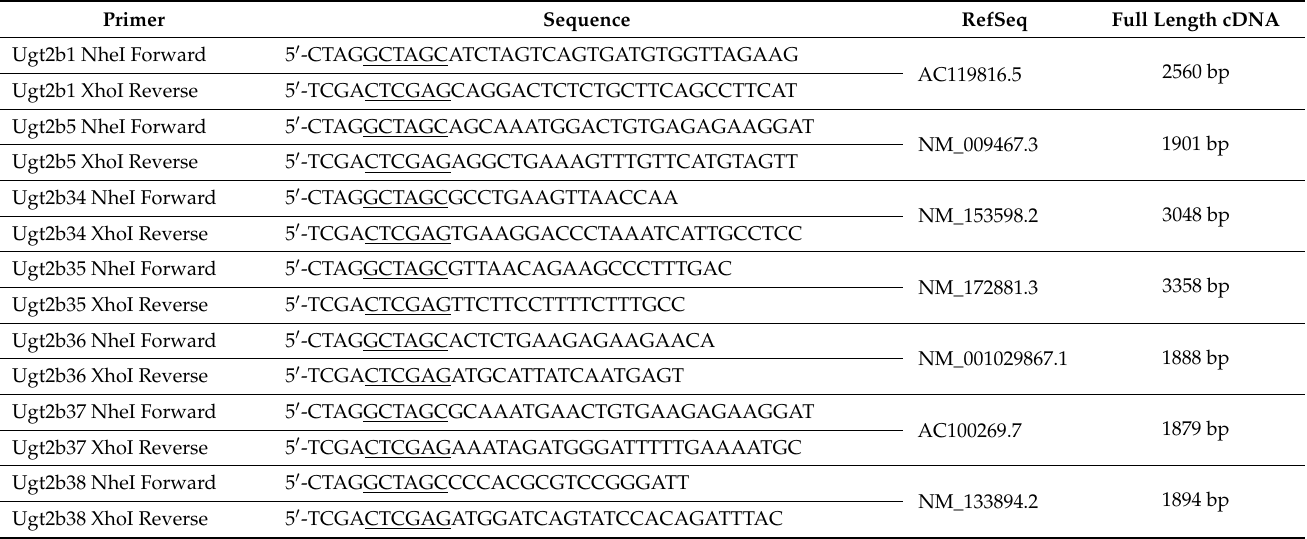
Table 2. Primer used for Ugt2b cDNA cloning (restriction sites are